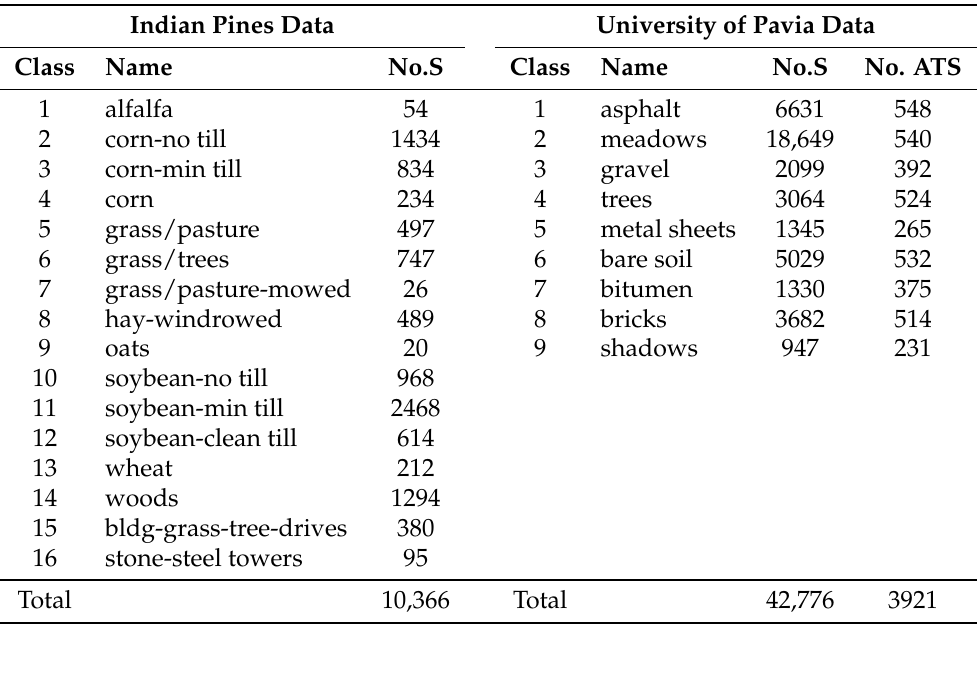
Table 1. Number of Samples (No.S) and available training samples (No. ATS) used in the experiments.